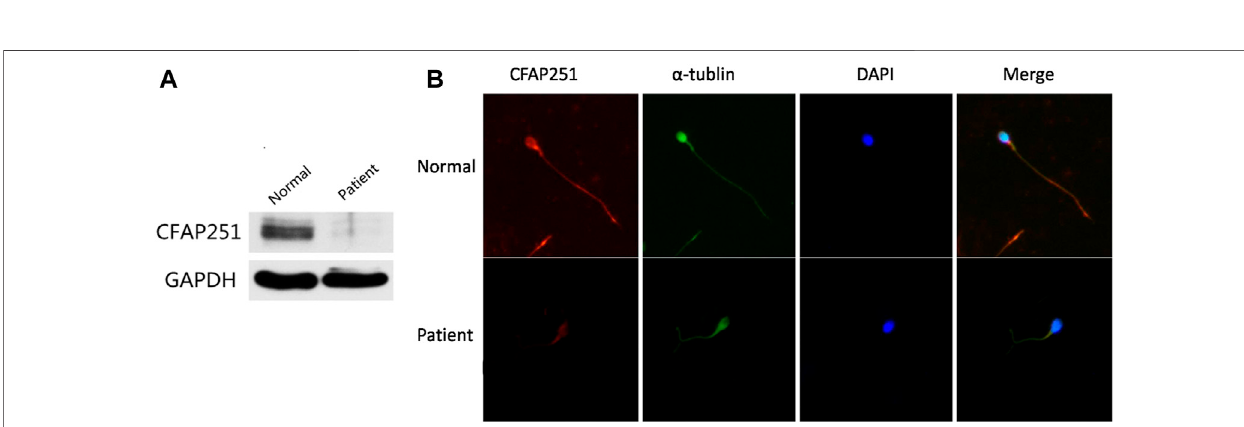
Frontiers in Genetics |